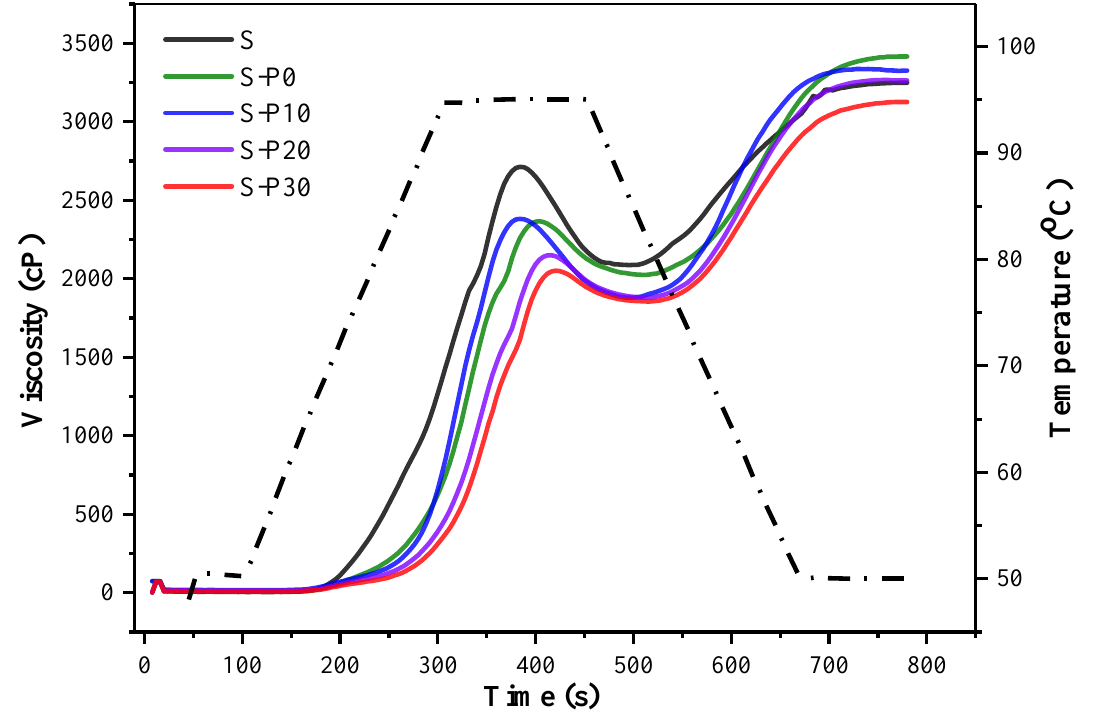
Figure 3. Pasting profiles of rice starch, and rice starch blended with protein or homogenized proteins. S, rice starch; S-P0, S-P10, S-P20 and S-P30 represented the rice starch blend with rice protein homogenized for 0, 10, 20 and 30 min, respectively.